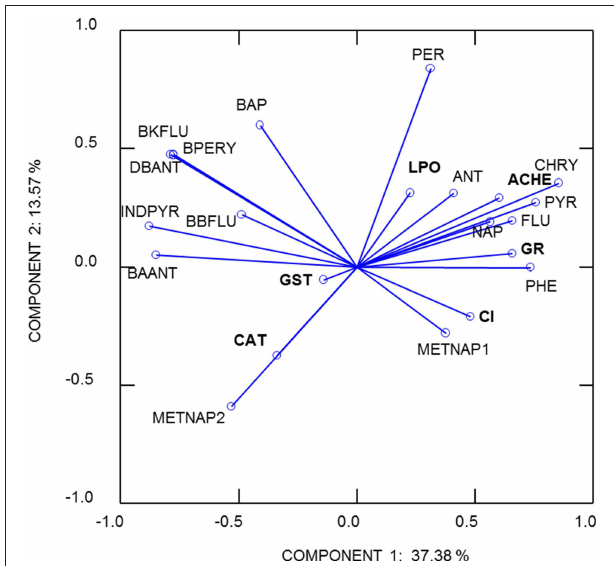
FIGURE 6 | Principal Component Analysis (PCA) on biomarkers and PAH compounds. GST, glutathione S -transferase; CAT, catalase; GR, glutathione reductase; LPO, lipid peroxidation; AChE, acetylcholinesterase; CI, condition index; METNAP1, 1-methylnaphthalene; METNAP2, 2-methylnaphthalene; ANT, anthracene; BAP, benzo[a]pyrene; PHE, phenanthrene; FLU, fluoranthene; NAP, naphthalene; PER, perylene; PYR, pyrene;